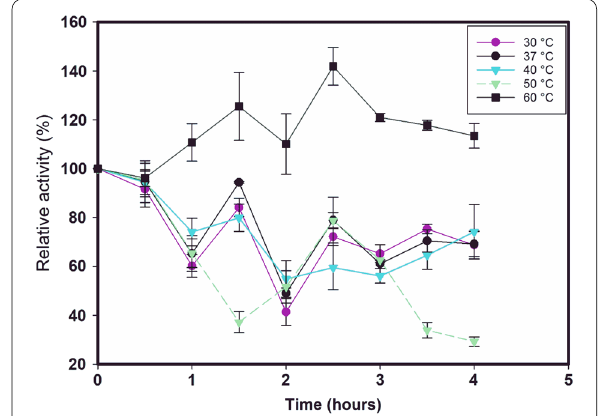
Fig. 4 LacMeta thermostability. LacMeta was previously incubated at temperatures 30 °C (purple circle), 37 °C (black circle), 40 °C (blue triangle), 50 °C (green triangle) and 60 °C (black square) Aliquots were